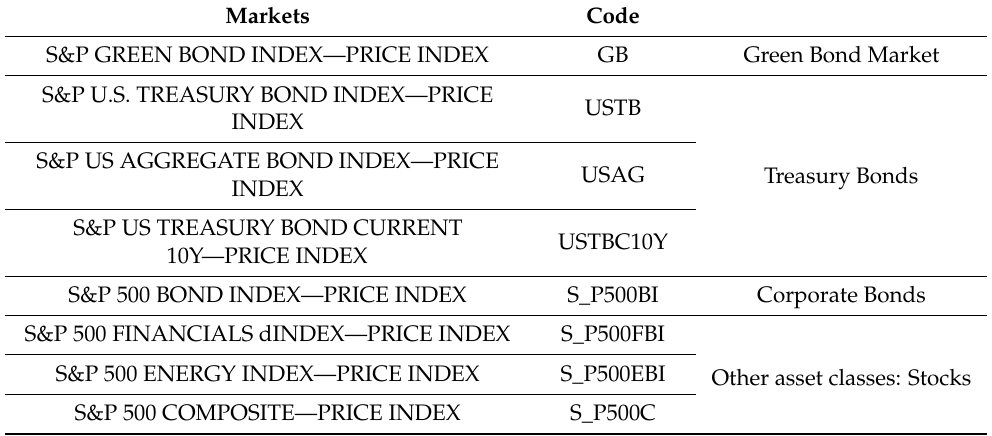
Table 1. Variable Description.